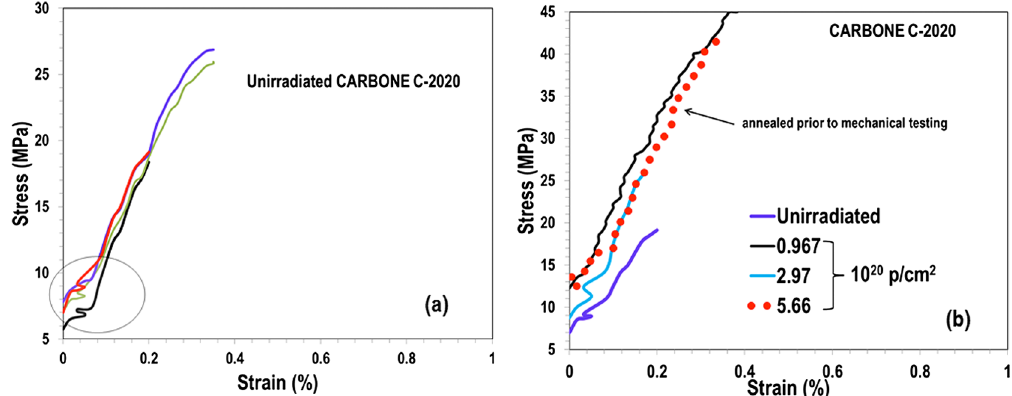
FIG. 13. Mechanical behavior of (a) unirradiated and (b) irradiated CARBONE C-2020